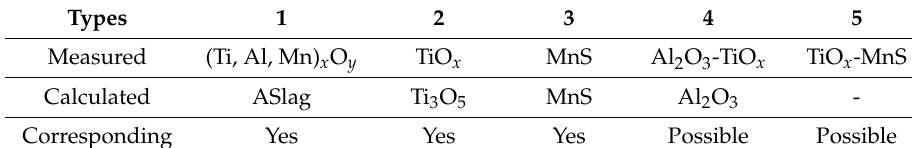
Table 3. Comparison of the predicted and measured inclusions in the selected steel [15].